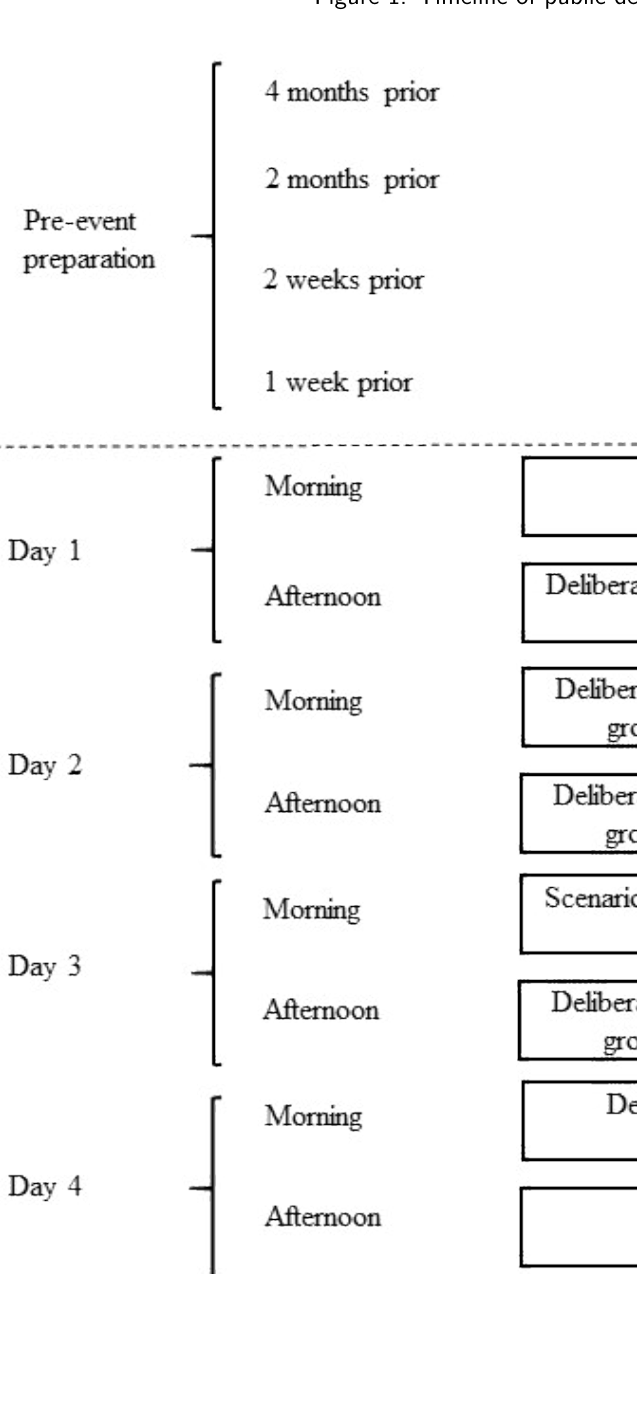
Figure 1: Timeline of public deliberation event and